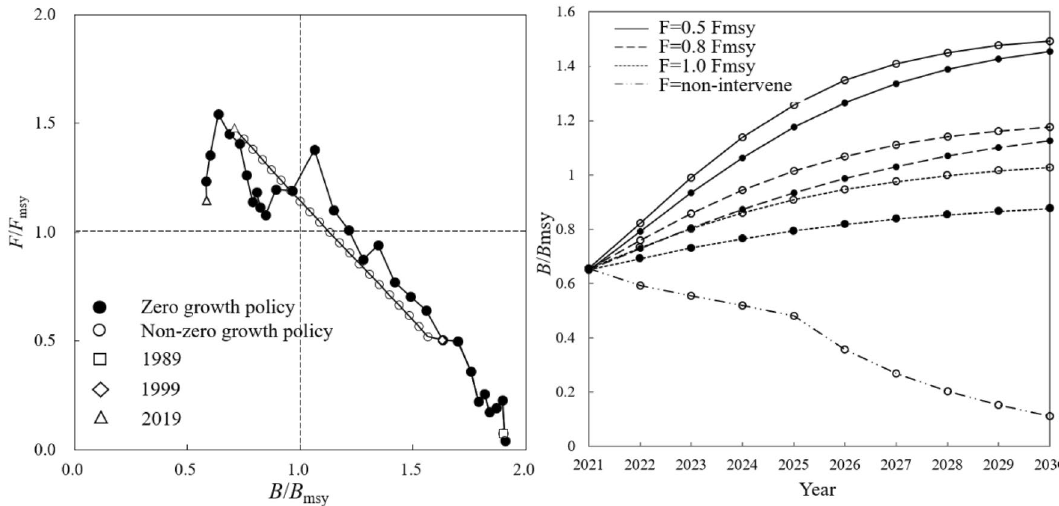
Figure 8. Rebuilding status of Sardinops sagax . Resource status in different quadrants following explanation in Fig. 2.